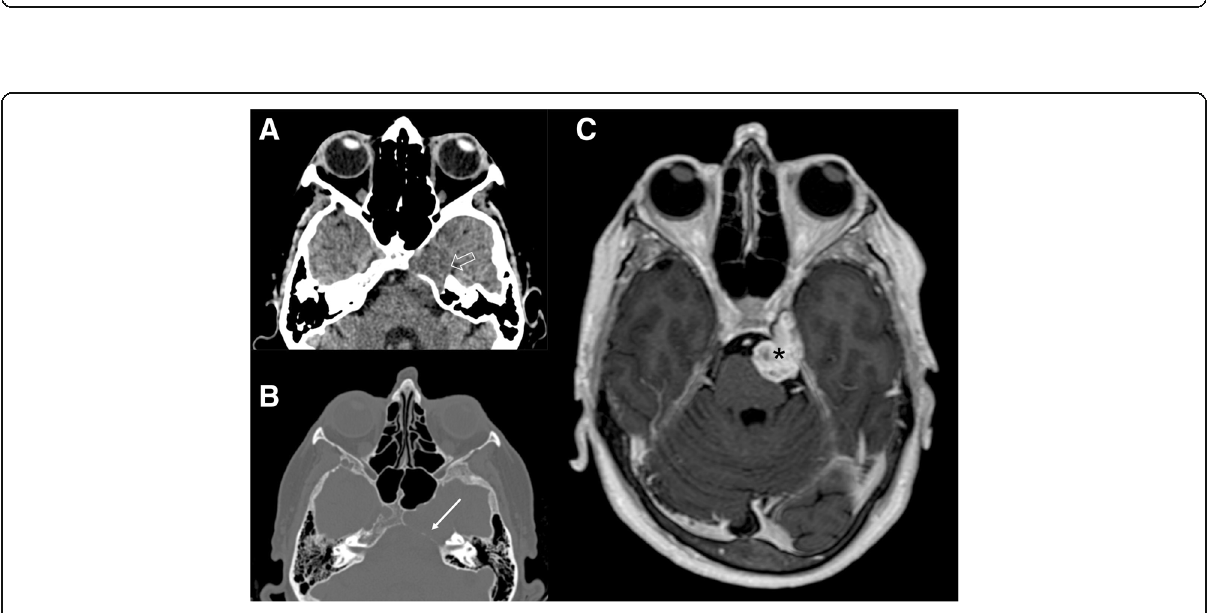
Fig. 12 Small trigeminal schwannoma. MRI T1-weighted post-gadolinium axial ( a ) and coronal ( b ) images show a homogeneous enhancing mass in the right Meckel ’ s cave (dotted circles)